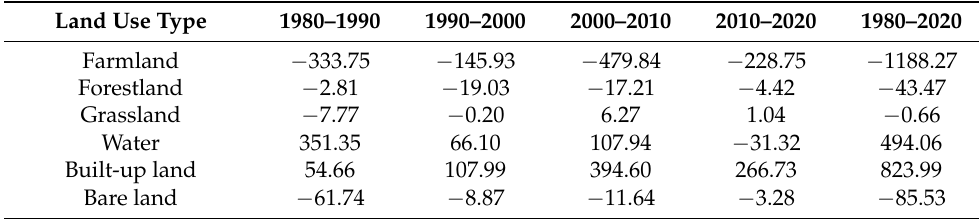
Table 4. The annual area of change (km 2 ) and the net total area of change (km 2 ) from 1980 to 2020 for six land use